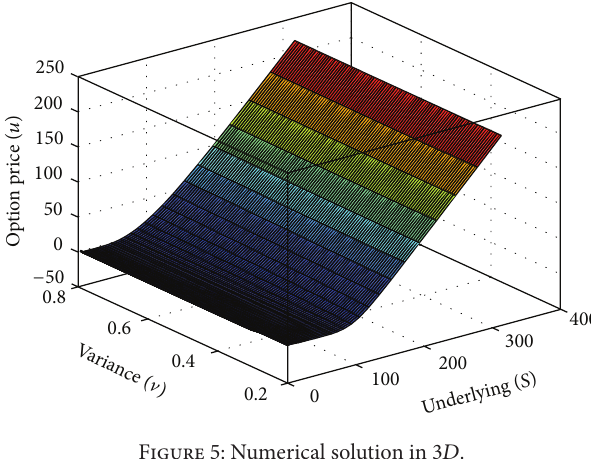
Figure 5: Numerical solution in 3 𝐷 . Table 1: Errors and convergence rates.